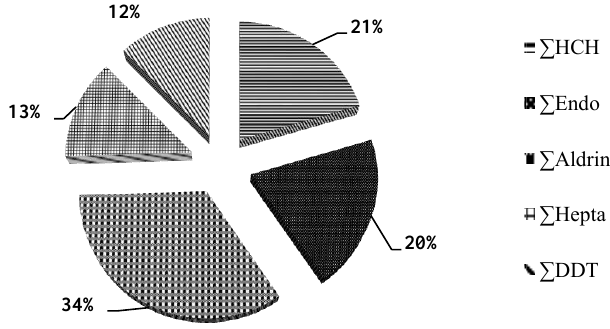
Figure 7. Organochlorine pesticide residues (ngL − 1 ) in water matrices of rivers of Bihar (BR) Area.